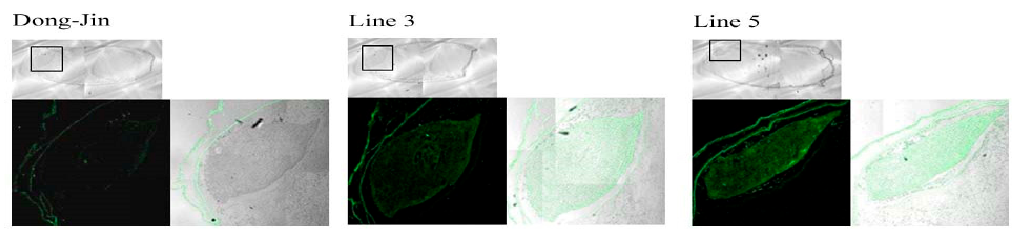
Figure 3. Immunofluorescence staining of AvMaSp in transgenic rice seeds. AvMaSp was found to be